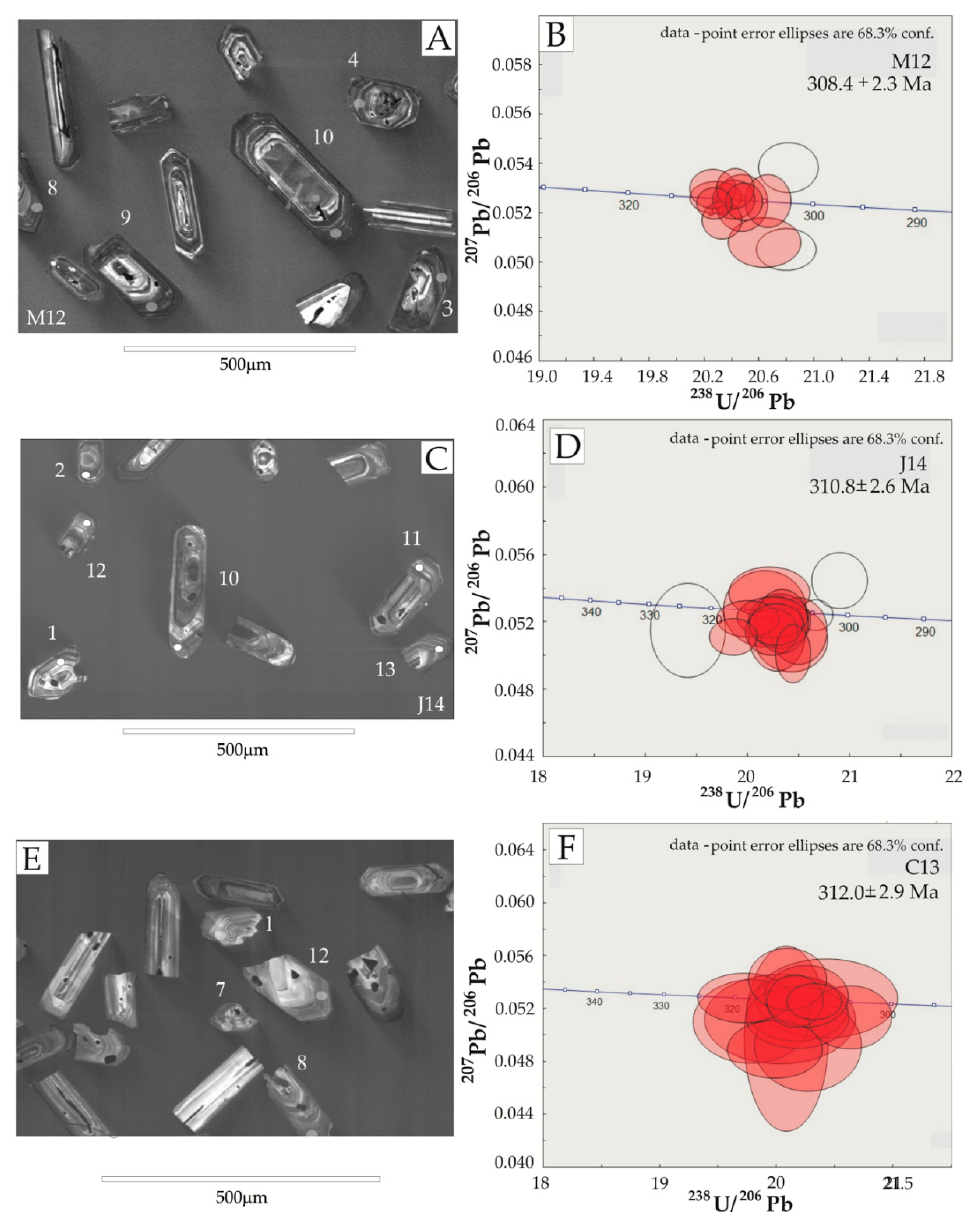
Figure 10. Cathodoluminescence images of selected zircon grains (ellipses show analysis locations) and concordia diagrams showing SHRIMP zircon U-Pb analyses (open symbols–analyses not included in the age calculations) of porphyritic granite from the KP, corrected for common Pb using 204 Pb; ( A , B ) Sample M12, from the Michałowice quarry; ( C , D ) Sample J14, from Janowice Wielkie near the area of the Miedzianka deposit; ( E , F ) Sample C13, from the area of the Czarnów As-polymetallic deposit.